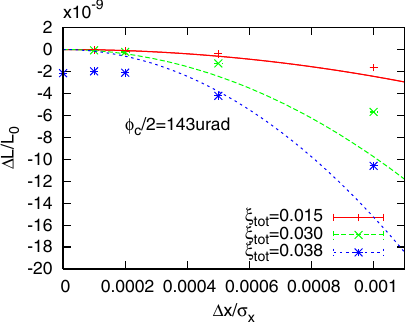
FIG. 21. Luminosity decrement as a function of the offset- noise amplitude for collision with a nonzero crossing angle. Results from a weak-strong simulation (plotting symbols) are compared with predictions from Eq. (38), for the working point ð ν x ; ν y Þ ¼ ð 0 . 31 ; 0 . 32 Þ